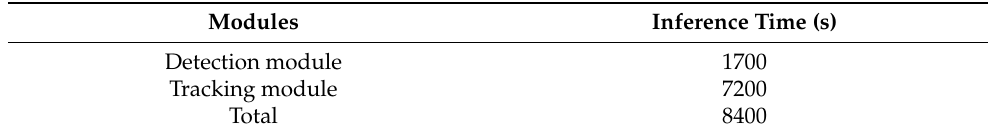
Table 11. The execution time of each module in the proposed tracking system.